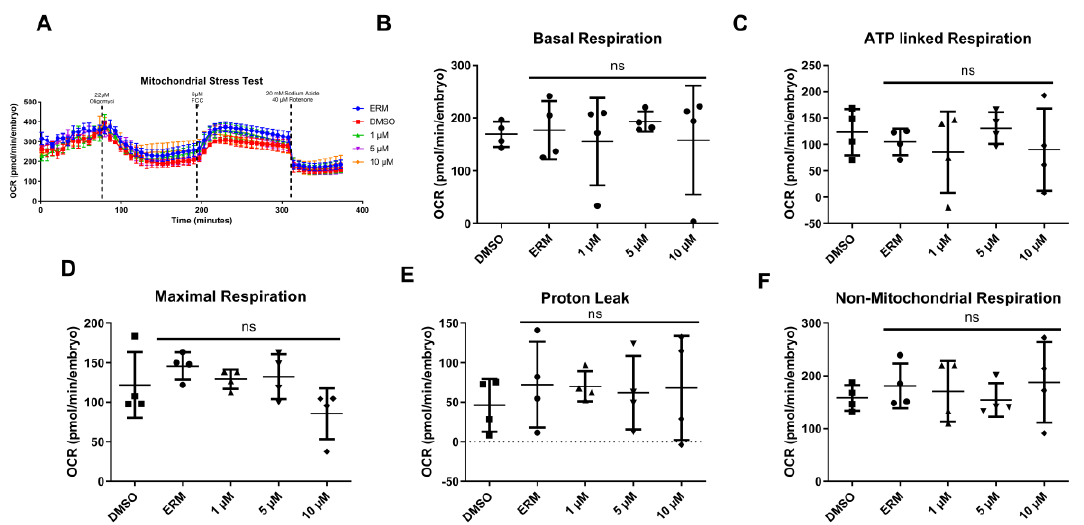
Figure 2. Oxygen consumption rate (OCR, pmol/min/embryo) for 30-h-old zebrafish embryos treated with PFTeDA for 24 h, beginning at 6 h. Effects of 1, 5, and 10 µM PFTeDA on mitochondrial endpoints compared to the vehicle control. ( A ) OCR over time, ( B ) Basal Respiration, ( C ) Oligomycin-induced ATP-Linked respiration, ( D ) FCCP-induced Maximal Respiration, ( E ) Proton Leak, and ( F ) Non-Mitochondrial Respiration. Each point is a biological replicate, and the horizontal line indicates the mean value of the group (mean ± S.D.) (one-way ANOVA with a Tukey’s multiple comparisons test, each group, n = 4 embryos from different exposure beakers). Symbols represent samples from different treatment groups. The ns = not significant.